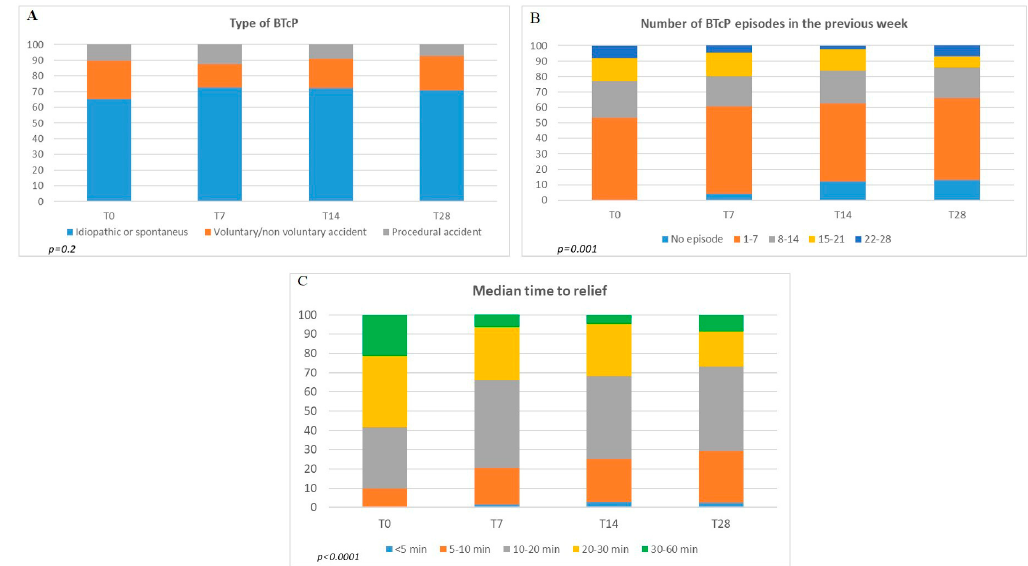
Figure 3. Breakthrough cancer pain (BTcP) results. ( A ) Features, ( B ) trend, and ( C ) response to